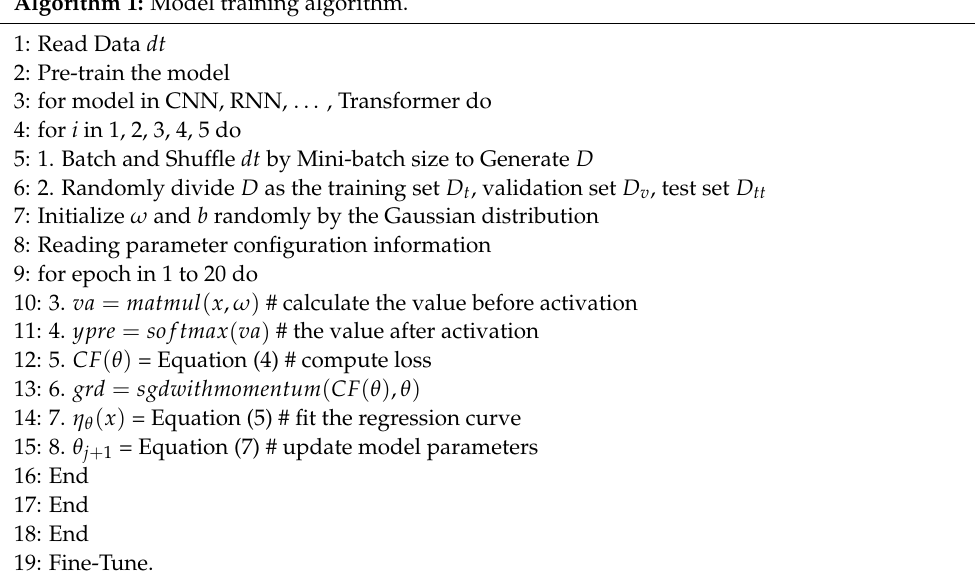
Algorithm 1: Model training